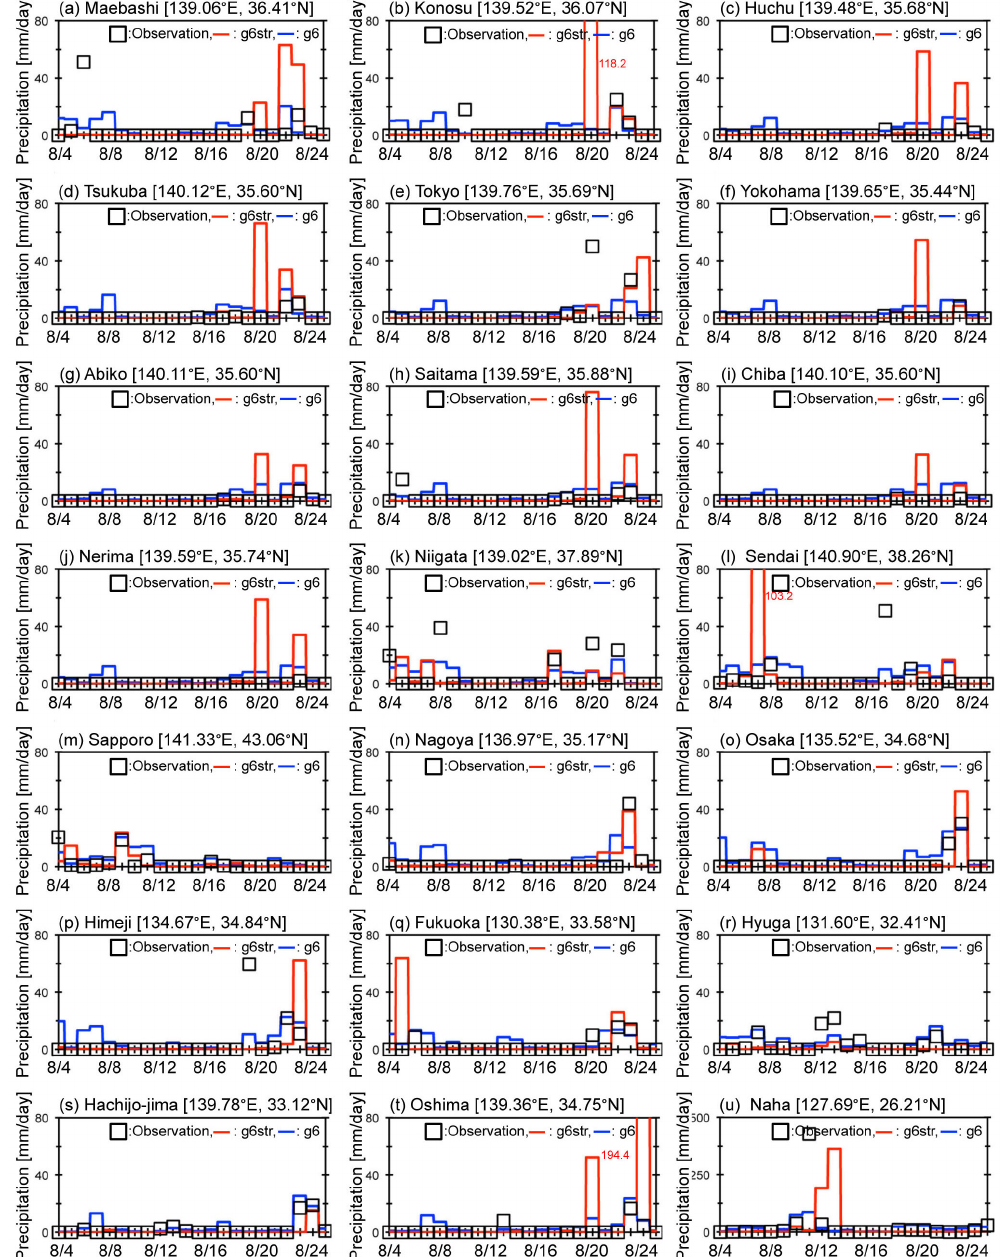
Figure 9. Temporal variations in the NICAM-g6str and NICAM-g6 simulated and observed precipitation amounts at 21 Japanese sites in August 2007. The comparison includes 10 sites in the Kanto area, (a) Maebashi, (b) Konosu, (c) Huchu, (d) Tsukuba, (e) Tokyo, (f) Yoko- hama, (g) Abiko, (h) Saitama, (i) Chiba, and (j) Nerima, 3 sites in northern Japan, (k) Niigata, (l) Sendai, and (m) Sapporo, 5 sites in western Japan, (n) Nagoya, (o) Osaka, (p) Himeji, (q) Fukuoka, and (r) Hyuga, and 3 remote islands, (s) Hachijo-jima, (t) Oshima, and (u)